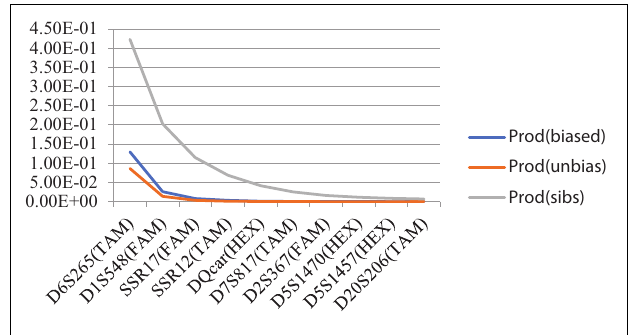
FIGURE 4 | Individual identification system ability curve.